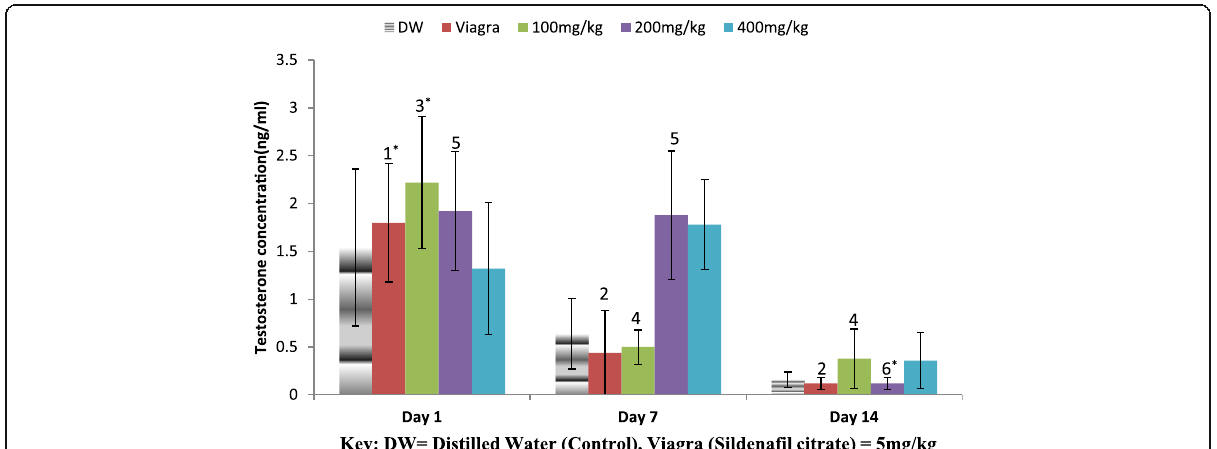
Fig. 6 Effect ofethanol extract of A. barbadensis root on the serum testosterone concentration of male rats. Bars with unlike letters are significantly different; bars without letters are significantly different from bars with letters while those with no letters are not significantly different from each other on each day. Bars with different numbers for the same dose group at different days are significantly different while those without numbers are not significantly different. All values are expressed as Mean ± SEM; n = 5;** P < 0.01; * P < 0.05